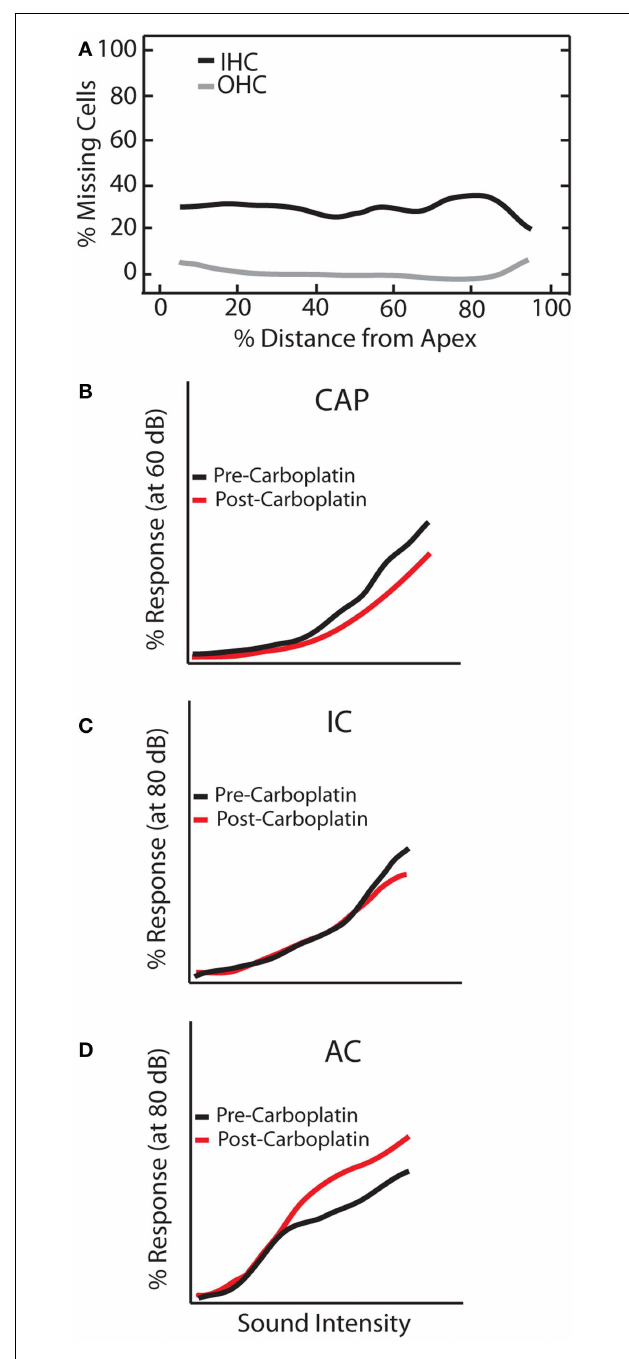
FIGURE 6 | Carboplatin-induced changes to peripheral and central auditory system . Schematic representation of the effects of carboplatin treatment (30mg/kg) on (A) hair cell loss, and amplitude-level functions from the (B) compound action potential (CAP), (C) inferior colliculus (IC), and (D) auditory cortex (AC). (A) Mean cochleogram showing the effects of carboplatin on OHC (gray lines) and IHC (black lines).While relatively little OHC loss was observed, an average of 30% of IHC are lost across the frequency-place map. (B–D) amplitude-level functions measured at 1kHz before (black lines) and after (red lines) carboplatin treatment [modified from Ref.